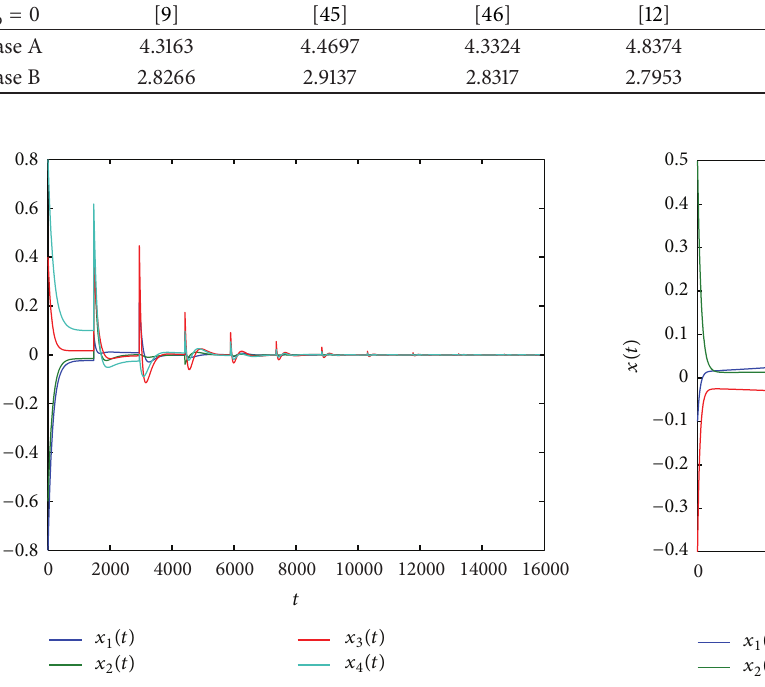
Figure 2: The simulation of Example 1 for ℎ = 𝑟 = 4.5312 , where the initial value is [−0.8,−0.6, 0.4, 0.8] 𝑇 , ℎ 𝐷 = 0.1 , 𝑙 = 3 .